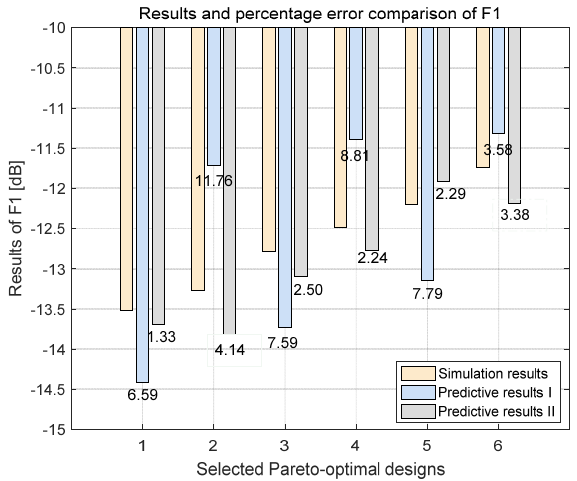
Figure 13. Error Comparison Histogram between Simulation Results and Prediction Results in Table 5.